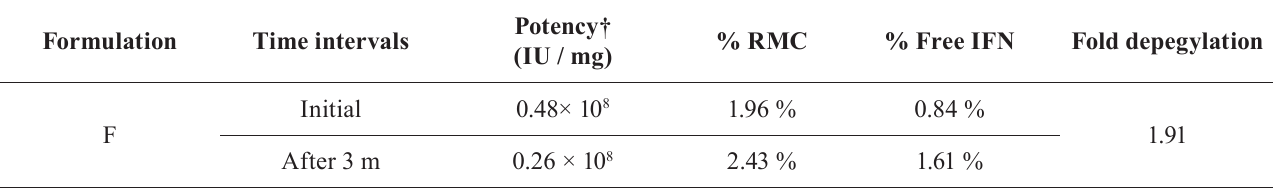
TABLE IV - Depegylation of peginterferon alfa-2b conjugate – Formulation C, D, E and F stored under Real-Time storage conditions